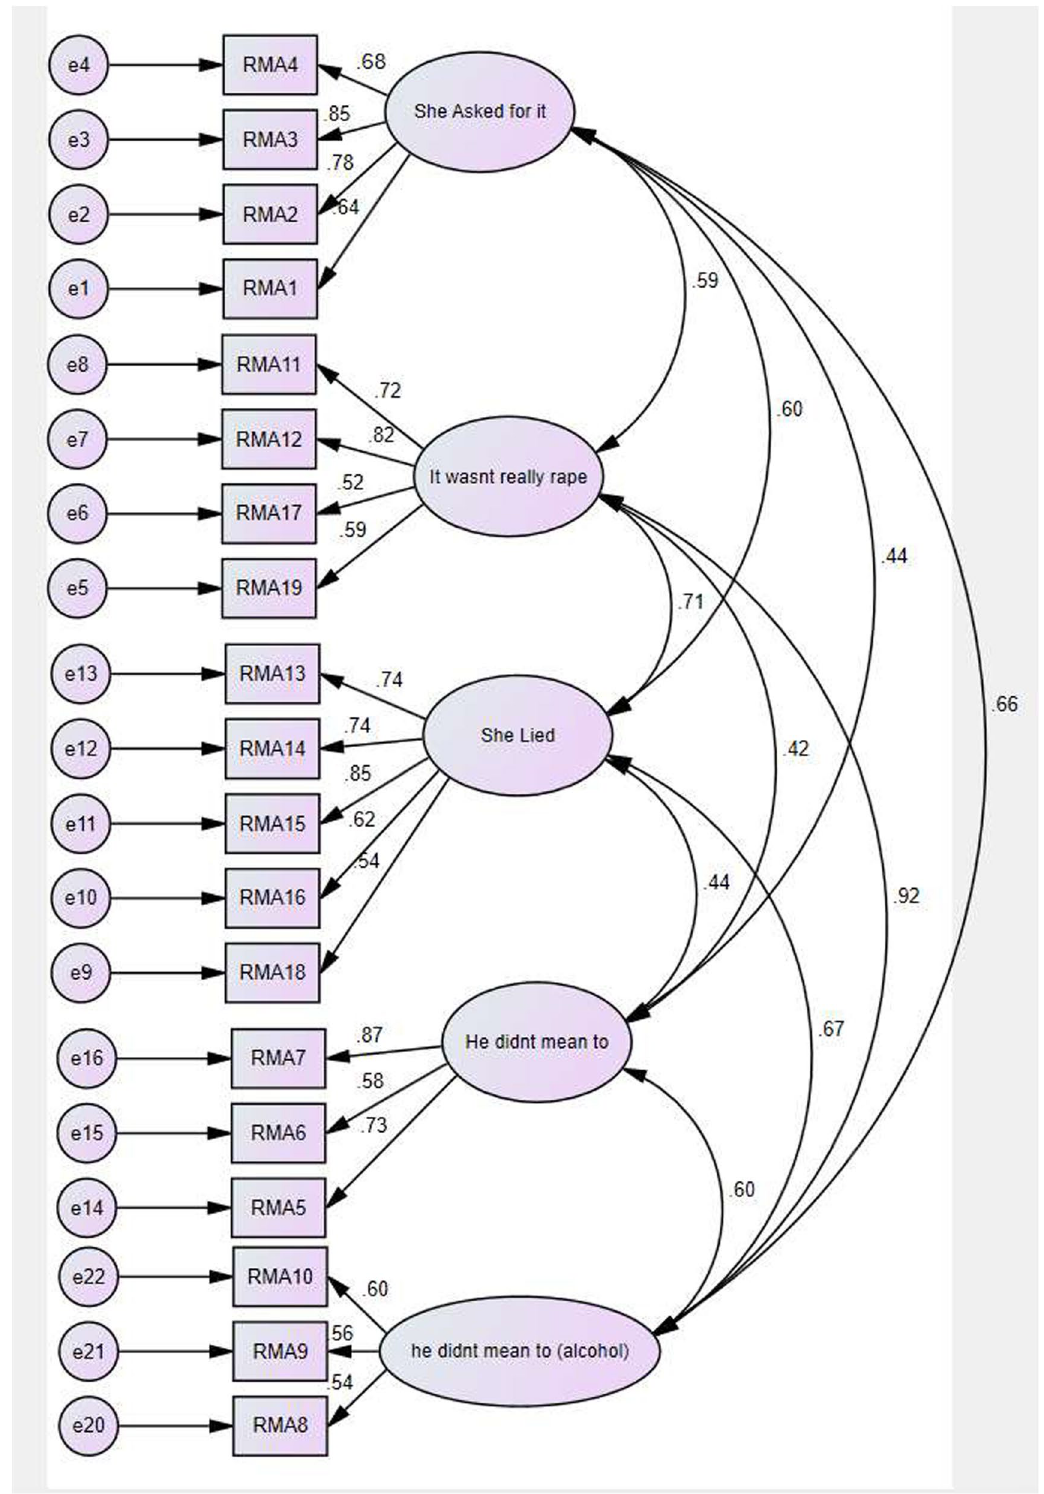
Fig. 1 Confirmatory factor analysis of the Illinois Rape Myths Acceptance. All factor loadings have been standardized and are significant ( p <